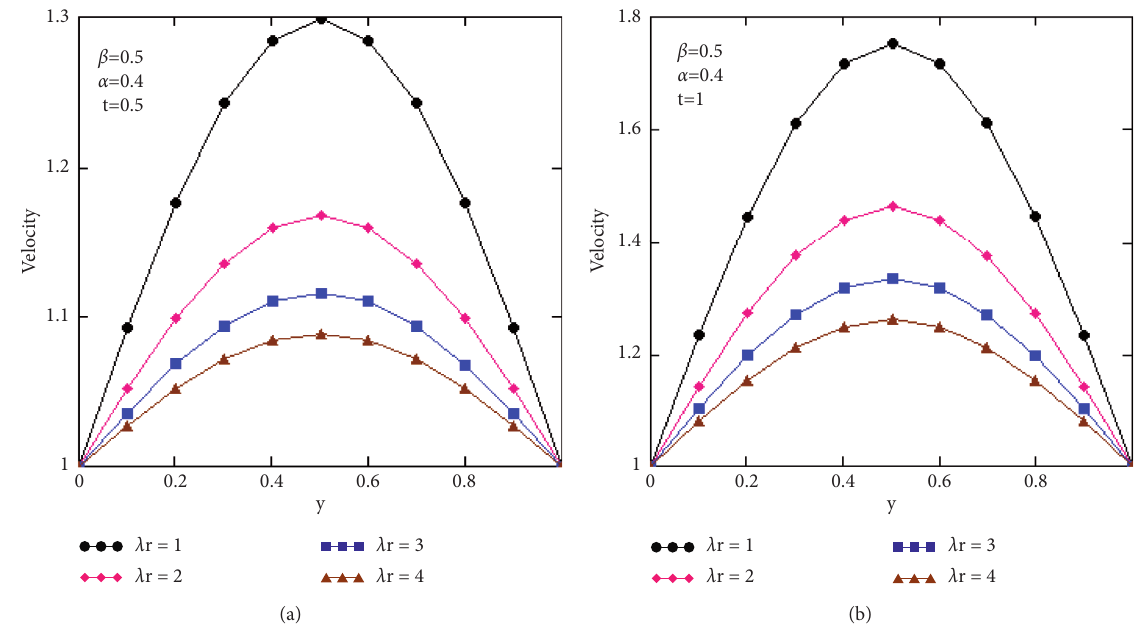
Figure 12: Profiles of dimensionless velocity versus y for variation of λ at altered values of time t , Gr � 5 , λ � 2 , Pr � 20 ,Q � 0 . 5, and f